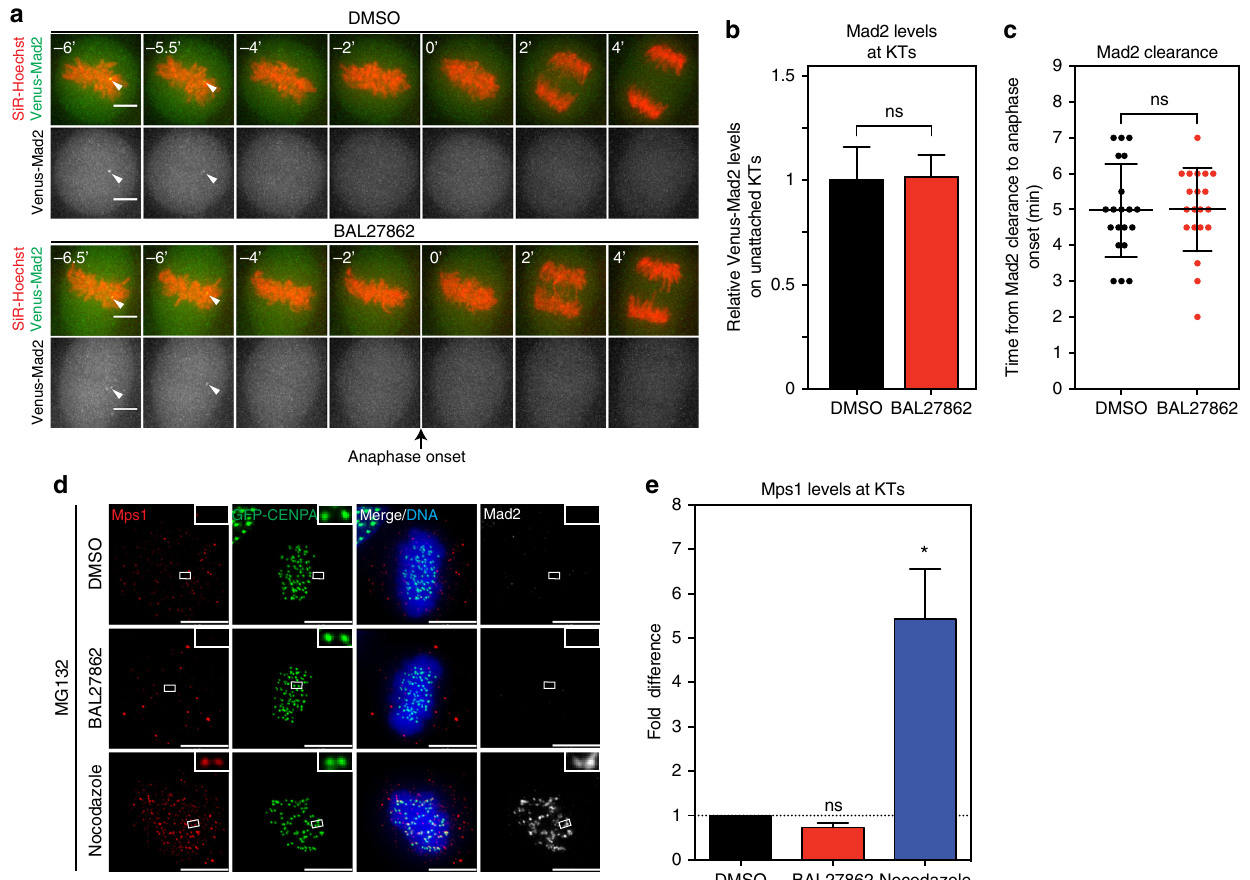
Fig. 4 Cells satisfy the SAC despite low MT occupancy. a Time lapse images of hTert-RPE1 Venus-Mad2 cells around anaphase onset (black arrow) treated with DMSO or 15 nM BAL27862. Chromosomes were visualized with SiR-Hoechst (red). White arrowheads indicate the Venus-Mad2 signal on the last unattached KT. b Quanti fi cation of Venus-Mad2 levels on unattached KTs in hTert-RPE1 Venus-Mad2 cells. N = 3, n = 51 – 58 unattached KTs; error bars indicate s.e.m. c Quanti fi cation of the time between the disappearance of the last Mad2 signal and anaphase onset, each dot represents one cell, N = 3-4, n = 20 cells, error bars represent s.d. of means, p = 0.95, two-tailed t -test, ns, not signi fi cant. d Immuno fl uorescence images of hTert-RPE1 GFP-CENPA cells (green) treated with DMSO or 12 nM BAL27862, blocked in metaphase with 10 μ M MG132, and stained with Mps1 (red) and Mad2 (white) antibodies; insets show exemplary sister-KT pairs. e Quanti fi cation of Mps1/GFP-CENPA ratio after background subtraction in images as shown in d , error bars indicate s.e.m., p = 0.012 in two-tailed ANOVA test, *signi fi cantly different in multiple comparison p = 0.038, N = 3, n = 320 – 700 KTs, ns, not signi fi